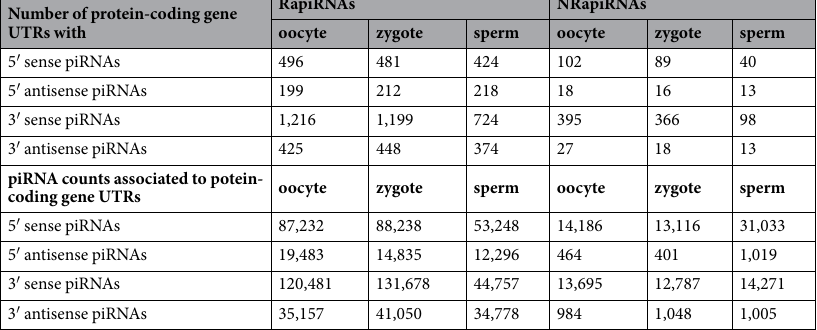
Table 3. Analysis of piRNAs associated with protein-coding 3 ′ and 5 ′ UTR gene regions. Only UTRs associated to more than 5 counts of normalized piRNA reads were